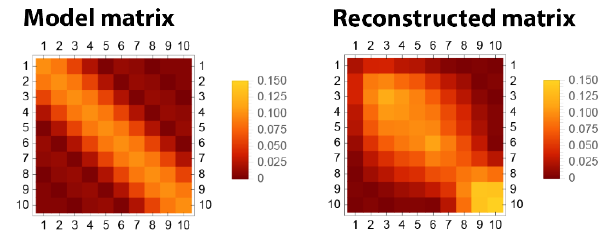
Fig. 2. True and measured coherence matrix of the collimated signal from the optical fiber (core diameter =